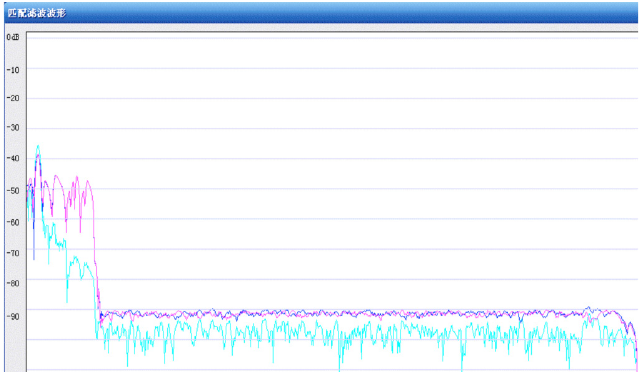
Figure 7. Baseband waves of the I and Q data after the